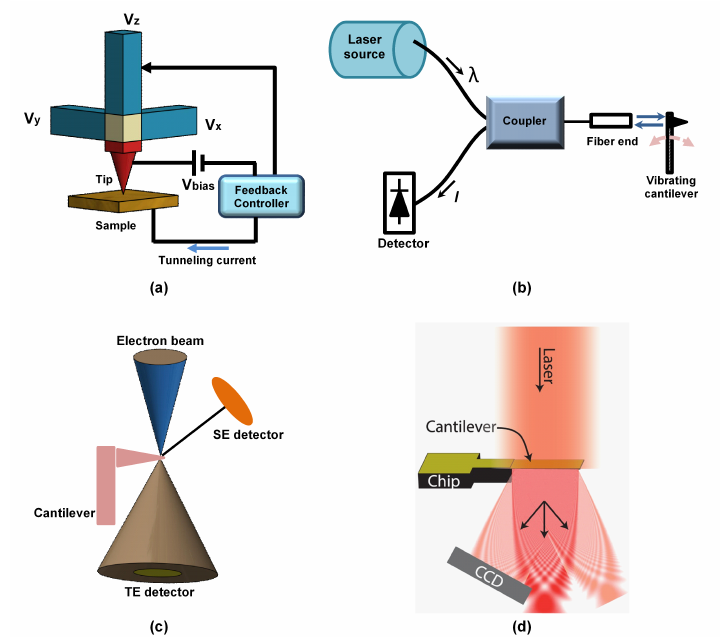
Figure 5. Schematics of ( a ) electron tunneling, ( b ) interferometric, ( c ) electron beam [132], and ( d ) optical diffraction microcantilever deflection detection systems